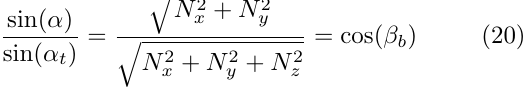
Figure 3: Transverse plane with indication of global co- ordinate system with origo in pitch point and the contact plane.